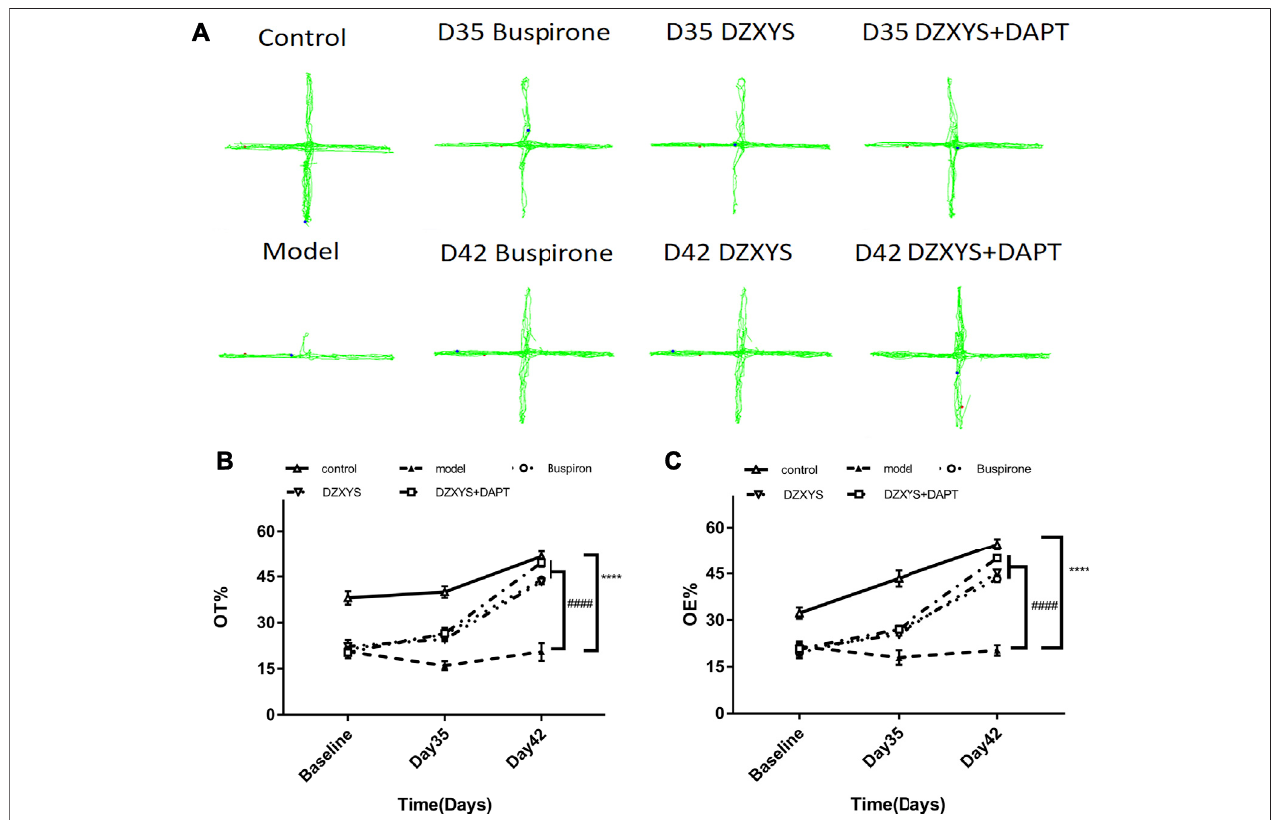
FIGURE5| TheresultsoftheEPMexperiment. (A) ThemovementtrackofratsintheEPMexperimentaldevice. (B) ThepercentageoftimeintheopenarmintheEPM test (C) PercentageofopenarmentriesintheEPMtest.**** p < 0.0001vscontrolgroup.#### p < 0.0001vs.modelgroup,two-wayANOVAofrepeateddatameasurements.